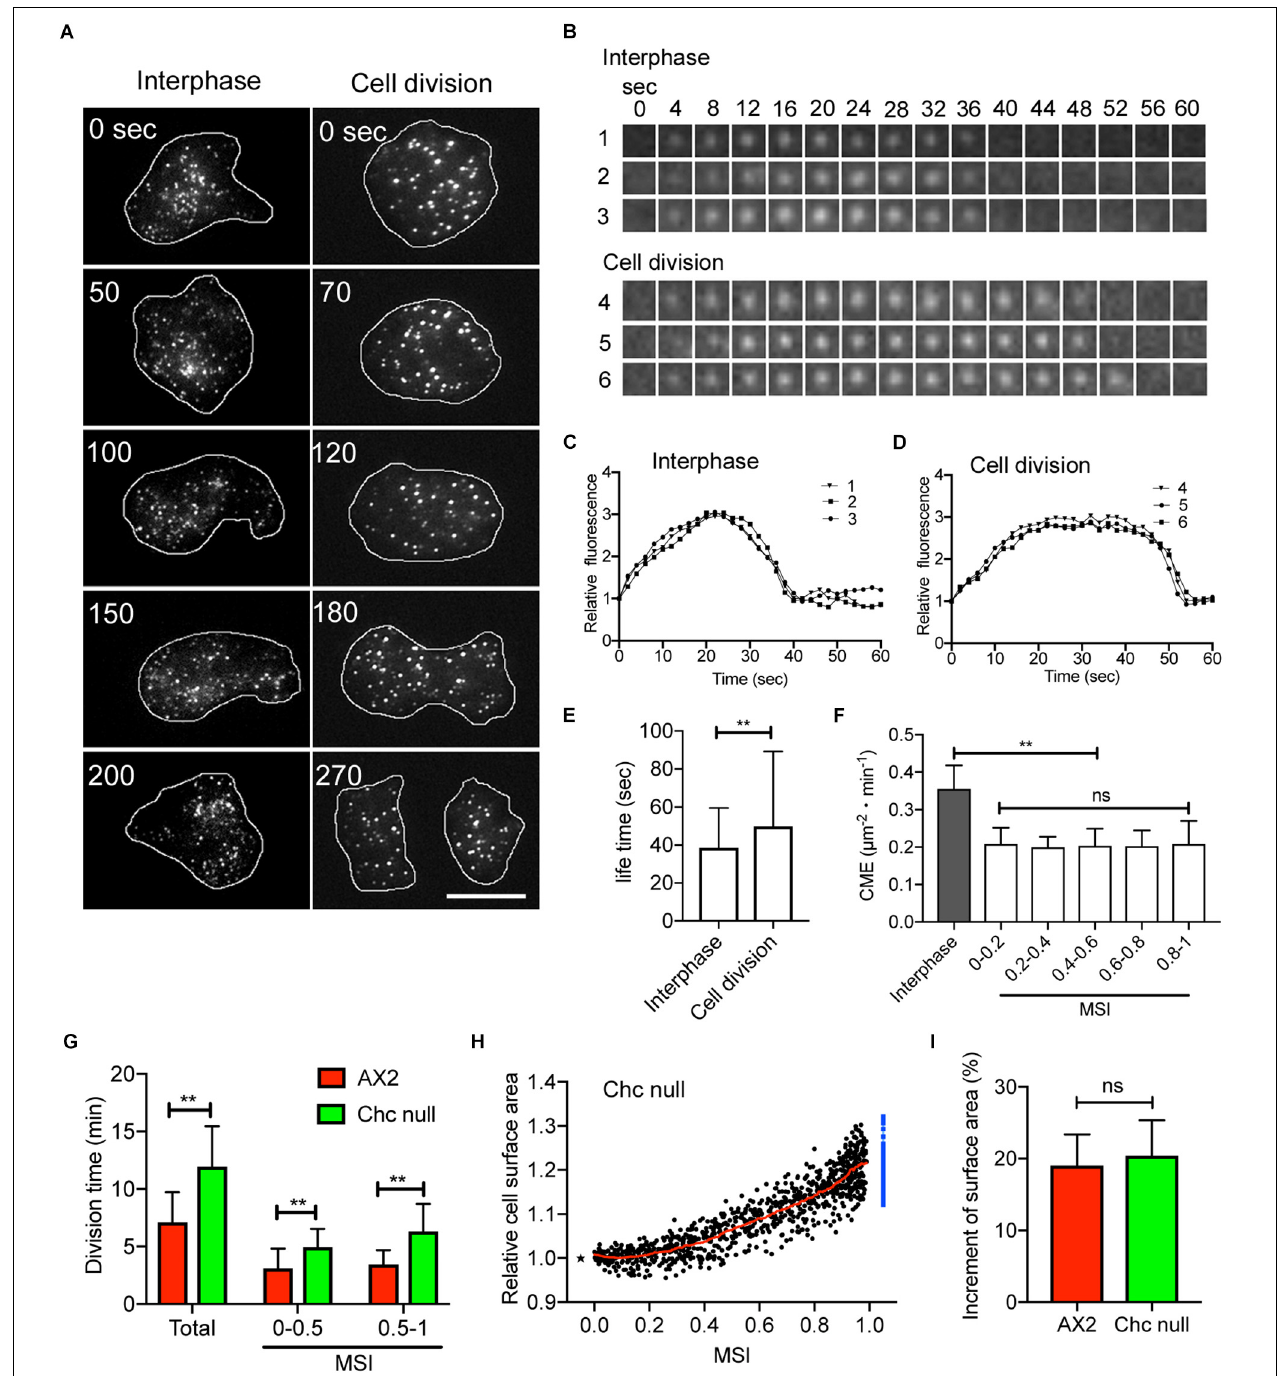
FIGURE 3 | Clathrin-mediated endocytosis (CME) is suppressed during cell division. (A) Typical total internal reflection fluorescence (TIRF) microscopic images of cells expressing GFP-clathrin at the interphase and mitosis stage. (B) Time courses of typical TIRF images of clathrin dots in cells at the interphase (1, 2, and 3) and mitotic (4, 5, and 6) stages, respectively. (C,D) Time courses of fluorescence intensities of the clathrin dots in the cells at the interphase and mitotic stages (B) . (E) Comparison of the lifetime of clathrin dots between interphase and dividing cells. Data are presented as the mean ± SD and analyzed by Student’s t -test. ** P < 0.001, n > 2,000. (F) CME in the interphase and during cell division (MSI 0–0.2, 0.2–0.4, 0.4–0.6, 0.6–0.8, and 0.8–1.0). Here, CME was counted as the number of disappearing dots per unit area and unit time ( µ m − 2 min − 1 ). (G) Comparison of division duration (Total, MSI 0–0.5, and MSI 0.5–1.0) between wild-type (AX2) and clathrin heavy chain ( chc ) null cells. Data are presented as the mean ± SD and analyzed by Student’s t -test. ** P ≤ 0.001, n ≥ 53. (H) Changes in total cell surface area versus MSI during cytokinesis in chc null cells ( n = 53). The surface area is normalized to 1 at the metaphase (asterisk). The sum of the surface area of the two daughter cells is represented by blue dots. The red line shows the average. (I) Comparison of the increase in cell surface area immediately before cytokinesis between wild type (AX2) and chc cells. Data are presented as the mean ± SD and analyzed by Student’s t -test. ns, not significant, P > 0.05, n ≥ 53.